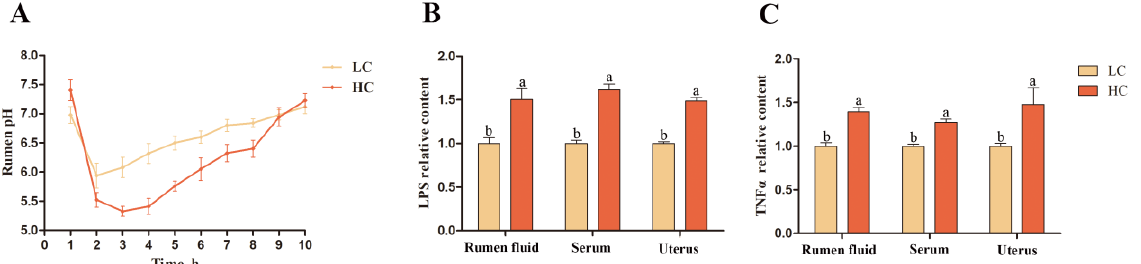
Figure 1. pH validation of the SARA model in sheep induced by high-concentrate feeding and com- parison of the relative concentrations of LPS and TNF α in the rumen fluid, serum, and endometrial tissue supernatant of sheep in the HC group to those in the LC group. ( A ) Rumen fluid pH trend. ( B ) Relative LPS concentration. ( C ) Relative TNF α concentration. Different lowercase letters indicate a significant difference at p < 0.05. LC, low-concentrate; HC, high-concentrate.